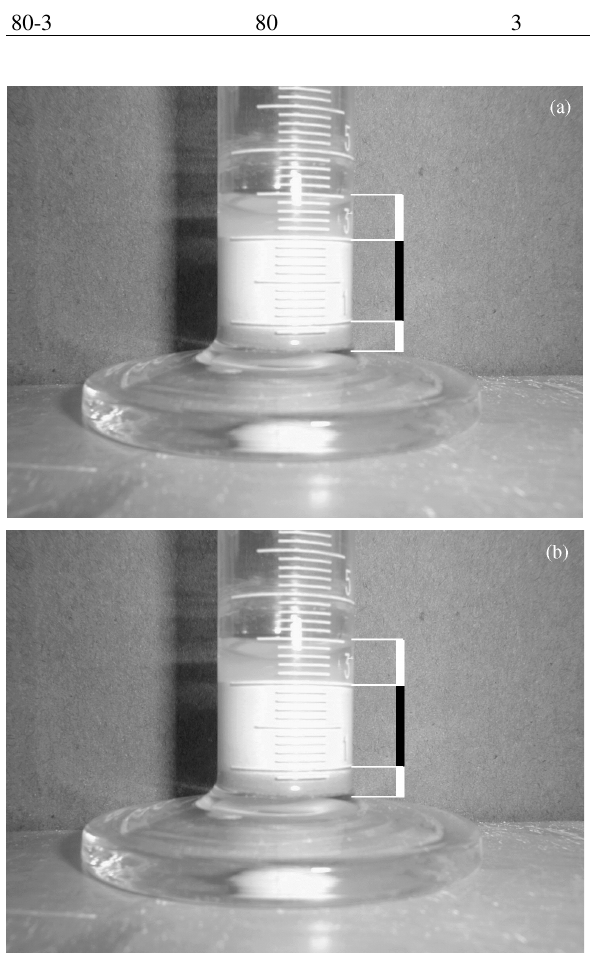
Figure 1. Sedimentation behaviour of two ZrO 2 /stainless steel different suspensions: A) 70 wt.% solid loading and 1 wt.% deflocculant, B) 80 wt.% solid loading and 3 wt.% deflocculant. Figure 2. Optical micrographs of the polished cross section of zir- conia/stainlesssteelcomposites:A)15vol.%metalandB)30vol.%metal. Lighter phase is metal and the darker phase is